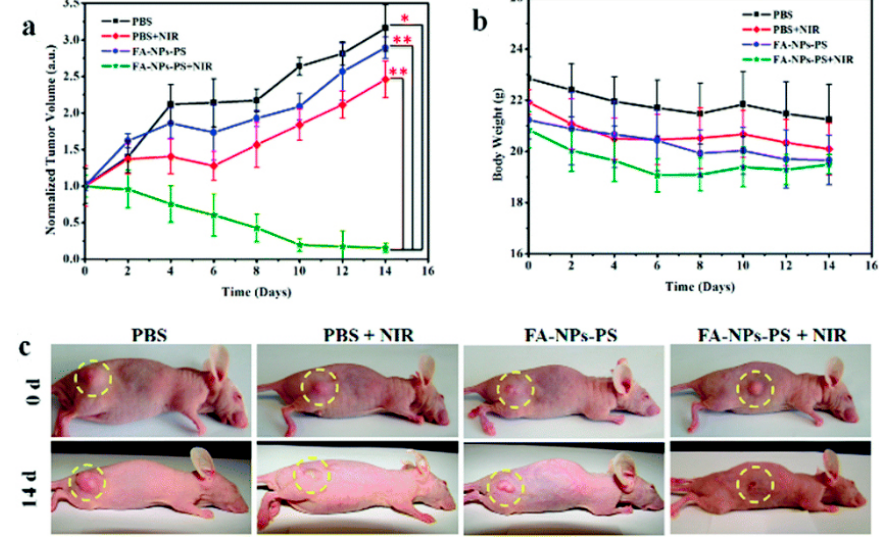
Figure 3. In vivo photodynamic therapy (PDT) characterization of MCF-7 tumor-bearing mice in different groups of phosphate-buffered saline (PBS), PBS + near infrared (NIR), folic acid-functionalized, photosensitizer-loaded Fe 3 O 4 @NaYF 4 : Yb/Er (FA-NPs-PS) and FA-NPs-PS + NIR, (Statistical analysis with Student's t test: * p < 0.05, ** p < 0.01). ( a ) the relative tumor volume change in different groups; ( b ) the body weight change of mice in different groups; and ( c ) images of different groups of MCF-7 tumor-bearing mice at the beginning and at the end of 15-day treatments. Reprinted with permission from [78].